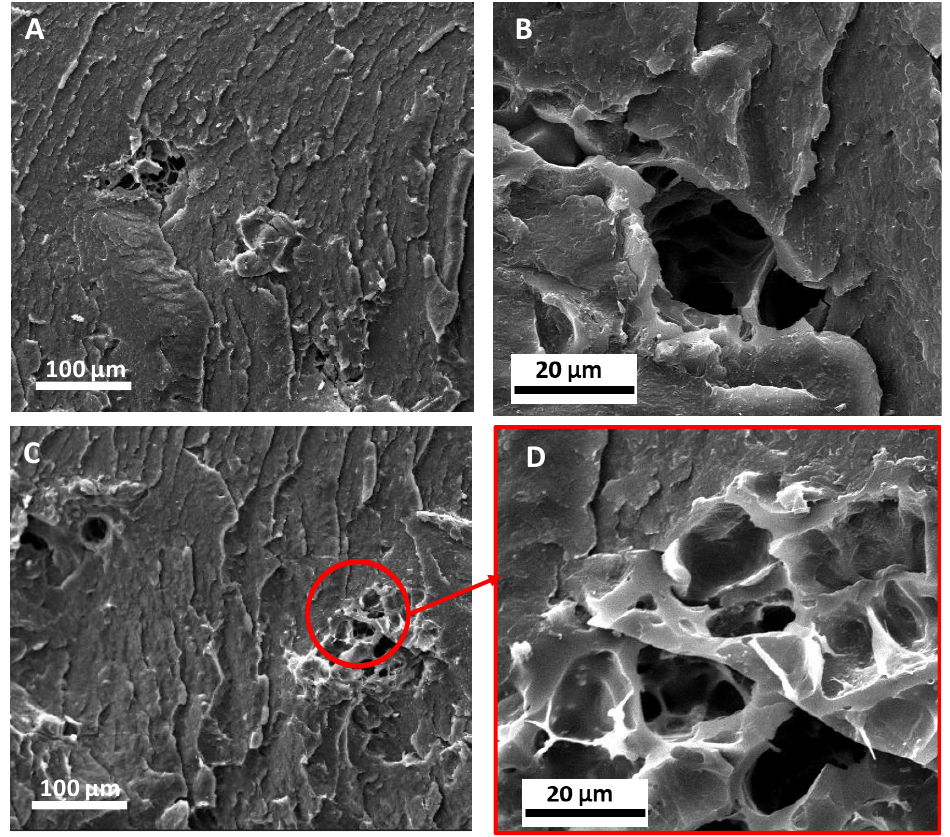
Figure 4. Scanning electron microscope (SEM) micrographs of PLA + 7.5BC_MM ( A , B ) and PLA + 7.5BC_SC ( C , D ) at different magnifications.